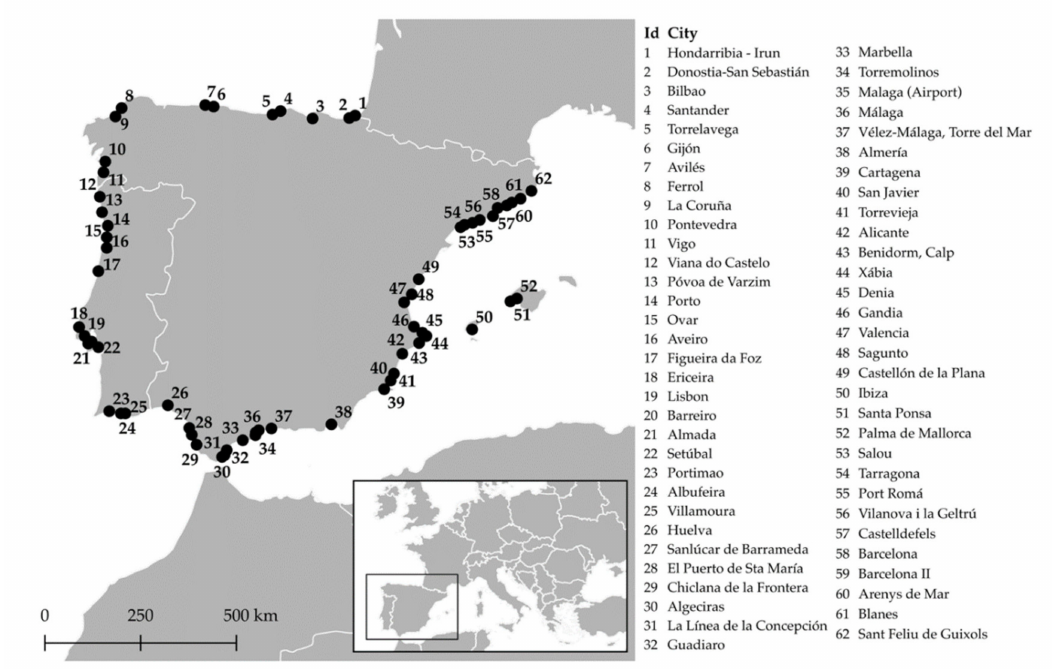
Figure 2. Selected 62 Iberian coastal cities in Spain and Portugal. Source: own